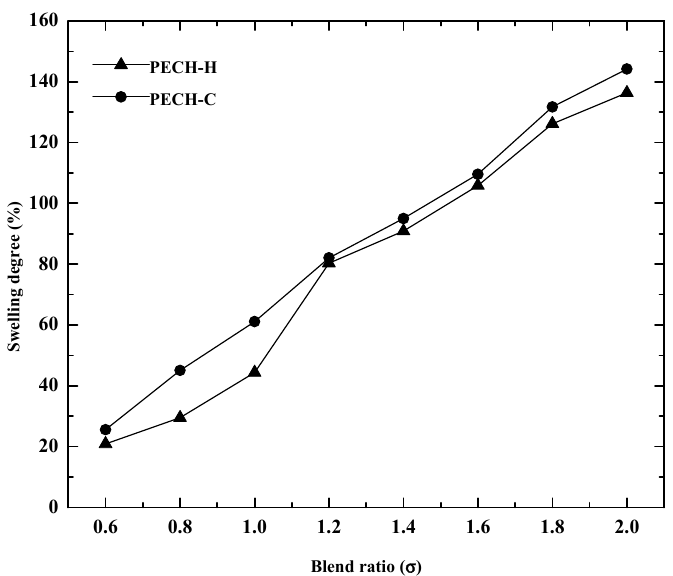
Figure 7. Impact of blend ratio on swelling degree for the PECH membranes at EDR of 2.